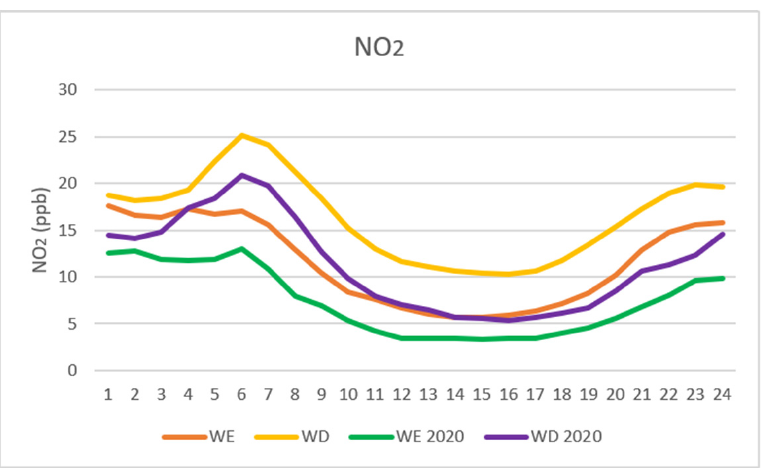
Figure 8. Nitrogen dioxide (NO 2 ) for the average period April to June 2010 – 2019 for weekends (WE) and weekdays (WD) and for April to June 2020 (WE 2020, WD 2020) at Toronto West.